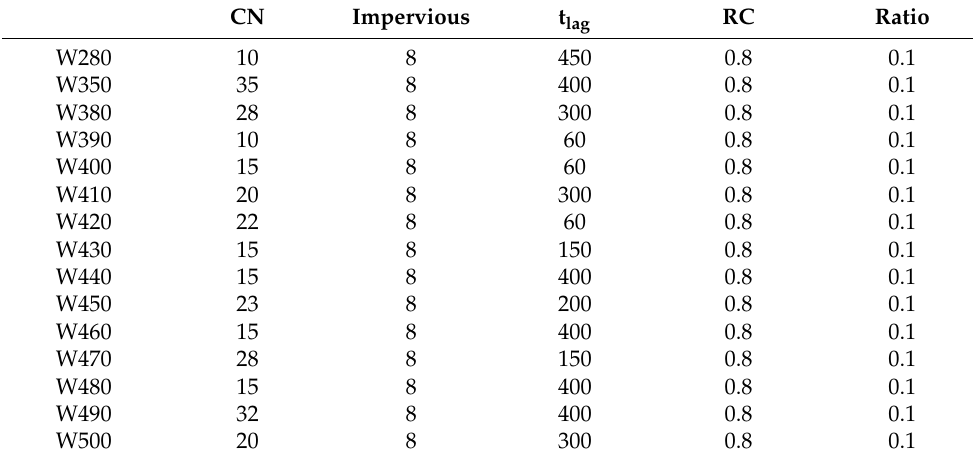
Table 1. Parameter optimization results of calibration period model.